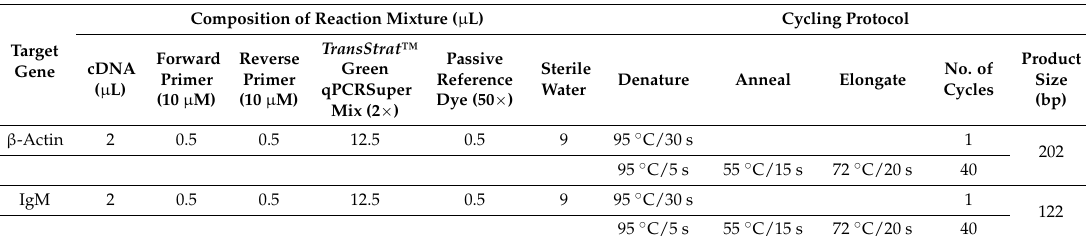
Table 4. Summary of conditions used in qPCR